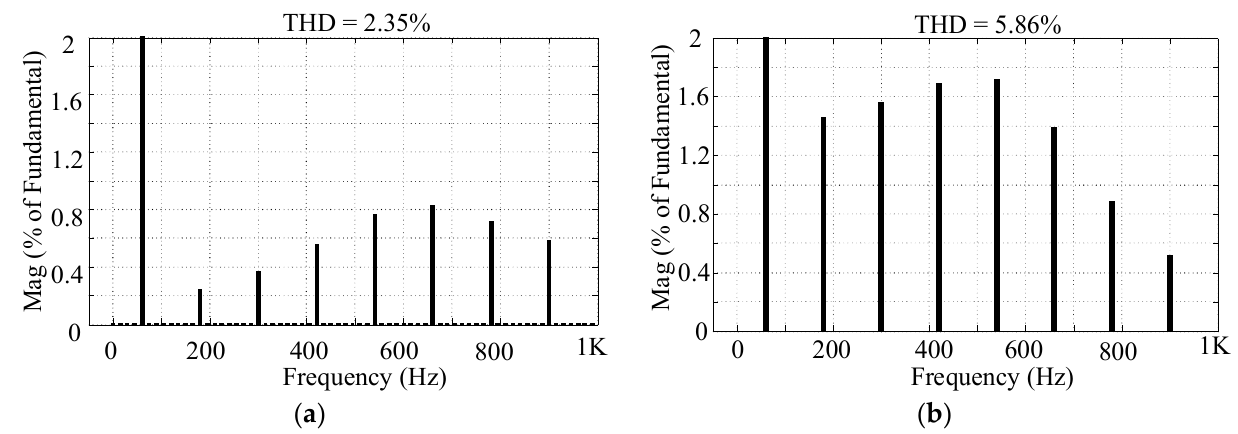
Figure 22. Simulation spectrums of the proposed topology for the boost in-phase operating mode when D = 0.1: ( a ) output voltage, ( b ) input current. THD = 3.83%